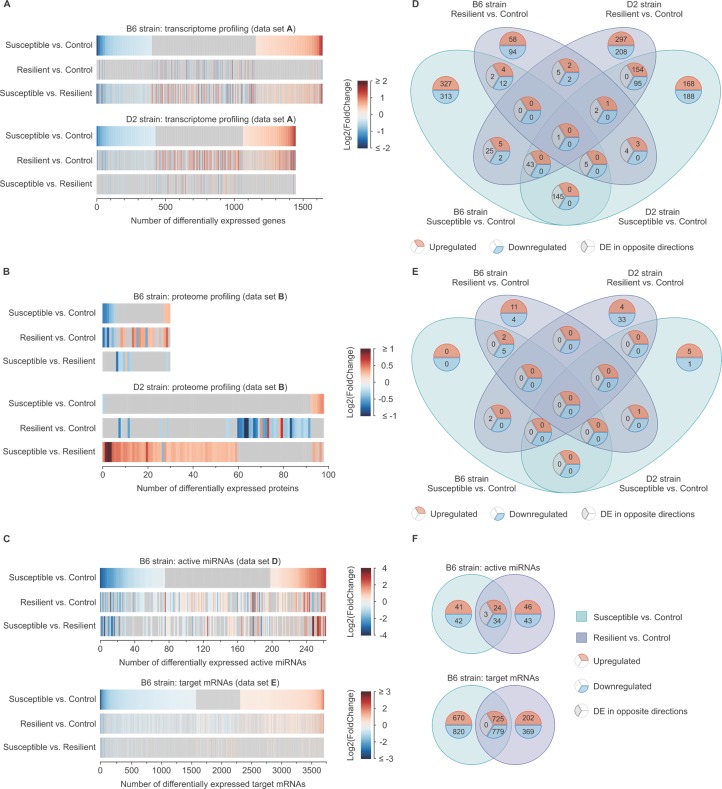
Distinct transcriptional stress response in the BNST of the D2 and B6 strains following CSDS.(A-C) Union heatmaps showing fold changes (FCs) of (A) significantly differentially expressed (DE; P < 0.05 and |FC| ≥ 1.2) genes (data set A), (B) proteins (data set B), and (C) active miRNAs and their target mRNAs (data sets D and E) following CSDS. The genes are rank-ordered by the FCs in the susceptible vs. control comparison, separately for each strain and–omics data set. (D-F) Venn diagrams showing overlap between significantly DE (D) genes (data set A), (E) proteins (data set B), and (F) active miRNAs and their target mRNAs (data sets D and E) following CSDS. B6: C57BL/6NCrl; CSDS: chronic social defeat stress; D2: DBA/2NCrl.